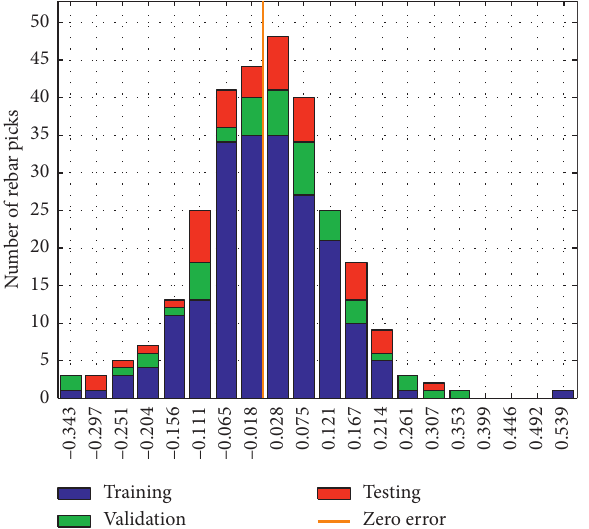
Figure 7: Error assessment for selected ANN